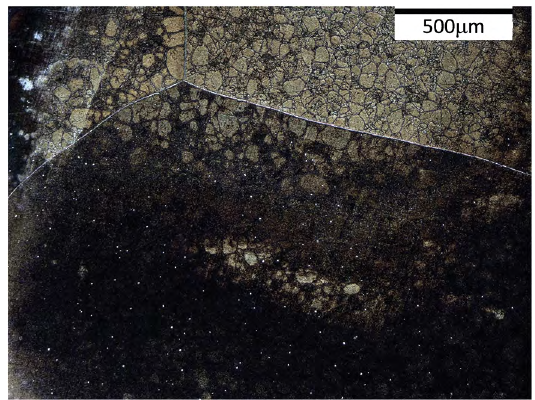
Figure 4. Micrograph of D2 condition. OM-50x. Behara